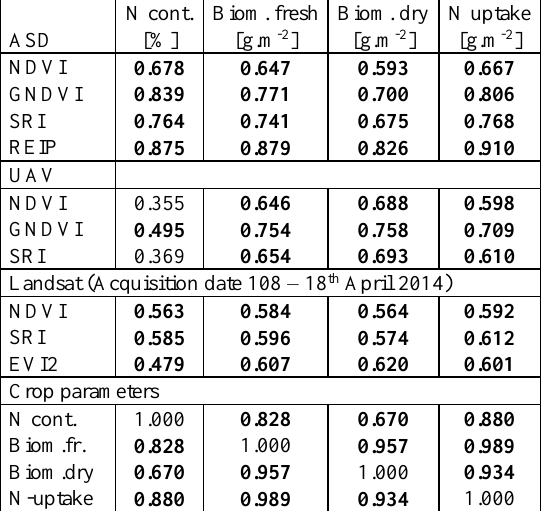
Table 2. Pearson correlation coefficients between vegetation indices from handheld spectrometer (ASD), UAV survey and Landsat OLI images (acquisition day marked) and crop parameters for BBCH 32. Bold values are statistically significant at 95 % level.